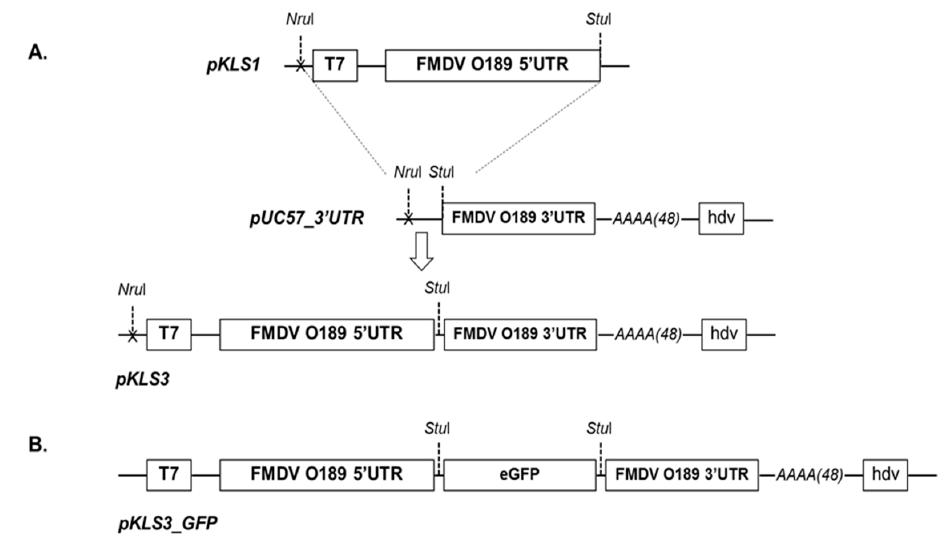
Figure 1. Construction of recombinant plasmids. ( A ) The DNA cassette containing T7 promoter and FMDV O189 5 ′ UTR in pKLS1 vector was removed by digesting with the restriction enzymes, Nru I and Stu I, and placed upstream of FMDV O189 3 ′ UTR, in plasmid pUC57_3 ′ UTR, resulting in the pKLS3 vector. The complete pKLS3 construct is an FMDV minigenome containing the essential FMDV cis-acting elements for viral replication/transcription and translation and a Stu I site for foreign gene insertion. ( B ) The enhanced green fluorescence protein (GFP) gene was inserted into pKLS3 at the Stu I site between FMDV 5 ′ and 3 ′ UTRs to generate a minigenome with a transfection reporter pKLS3_GFP. Table 2. Sequences of primers used for cloning a GFP gene into pKLS3 .